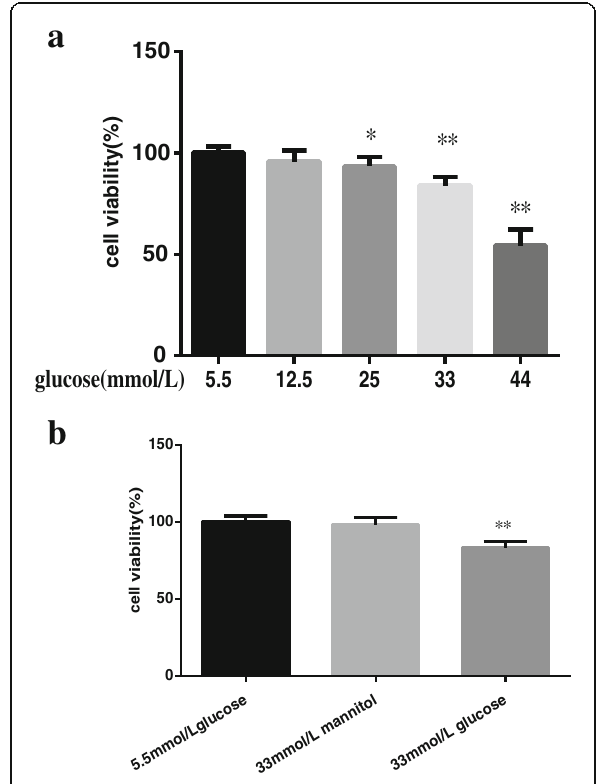
Fig. 1 a Cell viabilities in cells treated with various concentrations of glucose for 24 h. MTT assay was used to measure cell viability. Data were expressed as Mean ± SD. * P < 0.05 versus control. ** P < 0.01 versus control. b . Cell viabilities in cells treated with 5.5 mmol/L glucose group, 5.5 mmol/L glucose with 33 mmol/L mannitol and 33 mmol/L glucose groups for 24 h. MTT assay was used to measure cell viability. Data were expressed as Mean ± SD. ** P < 0.01 versus